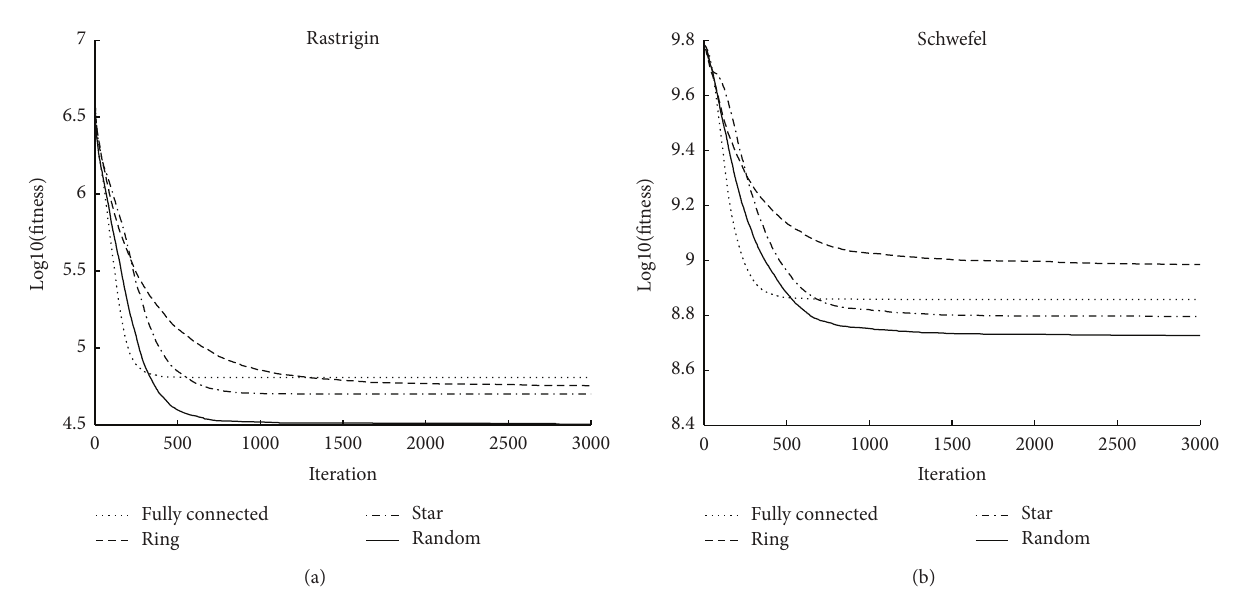
Figure 3: Comparison of evolutionary trend between four topologies (Rastrigin and